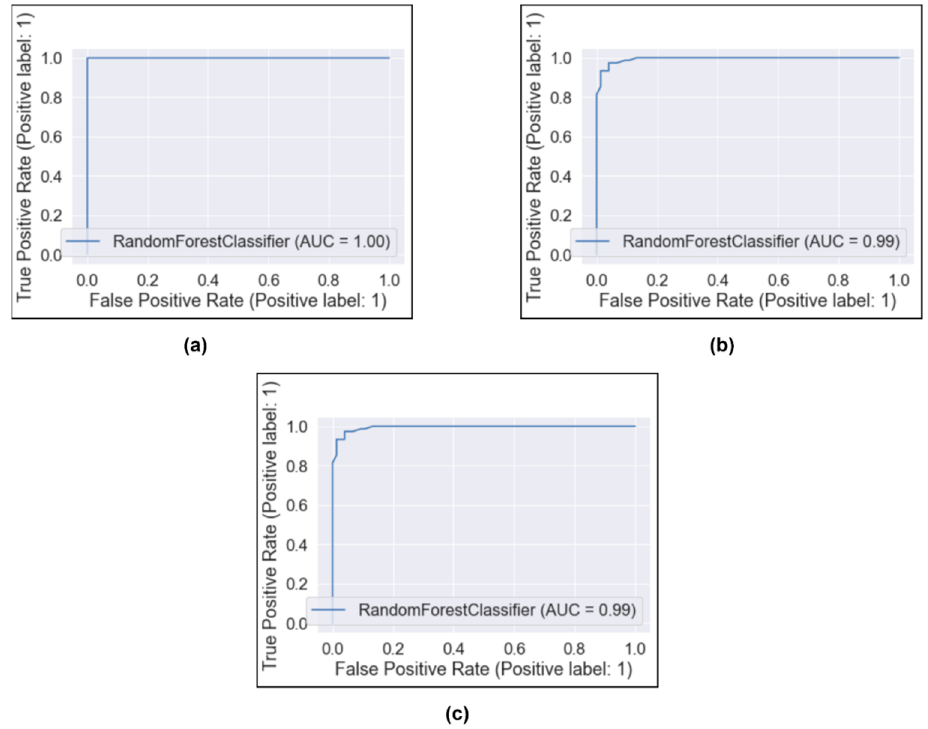
Figure 11. AUC with different splits: ( a ) Train–test split 90–10%, ( b ) Train–test 80–20%, ( c ) Train–test 70–30%.